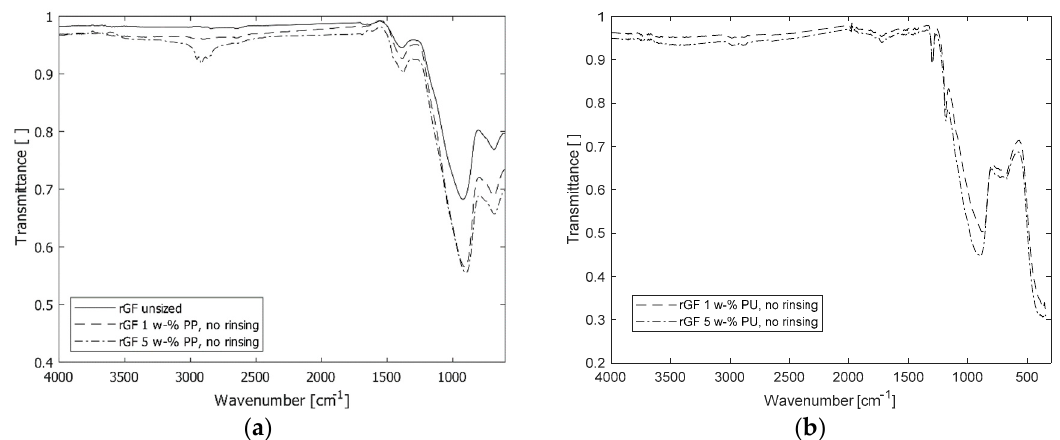
Figure 4. The FTIR spectra of the rGF samples before sizing and after 1 and 5 w-% PP sizing ( a ) and PU sizing ( b ) solutions.